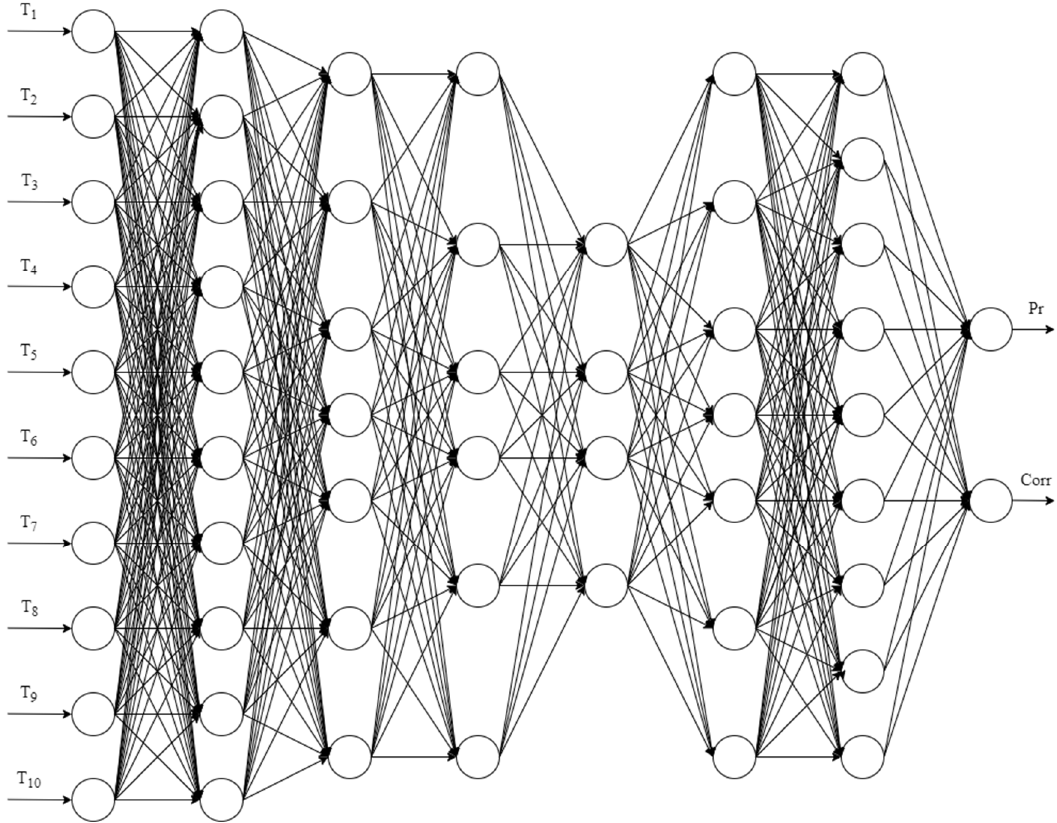
Figure 16. The structure of the artificial neural network for the identification of errors with the optimal structure.